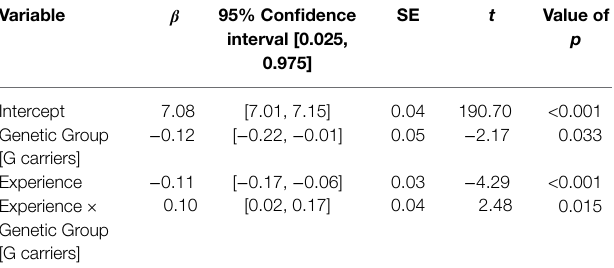
TABLE 2 | Results of the multiple linear regression to investigate the effects of Experience, Genetic Group, and their interaction on ORT.